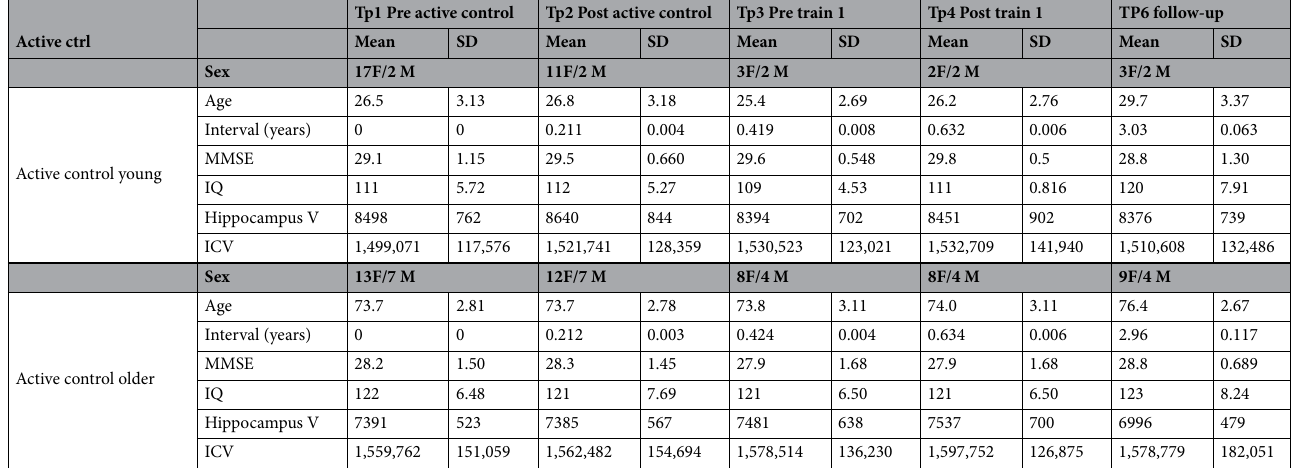
Table 2. Demographics of the young and older active control groups. Time points 1 and 2 correspond to the assessments conducted before and after the active control period. Time points 3 and 4 correspond to the assessments conducted before and after the optional training period offered to the participants after completion of the active control condition. Values on hippocampal volume refer to both